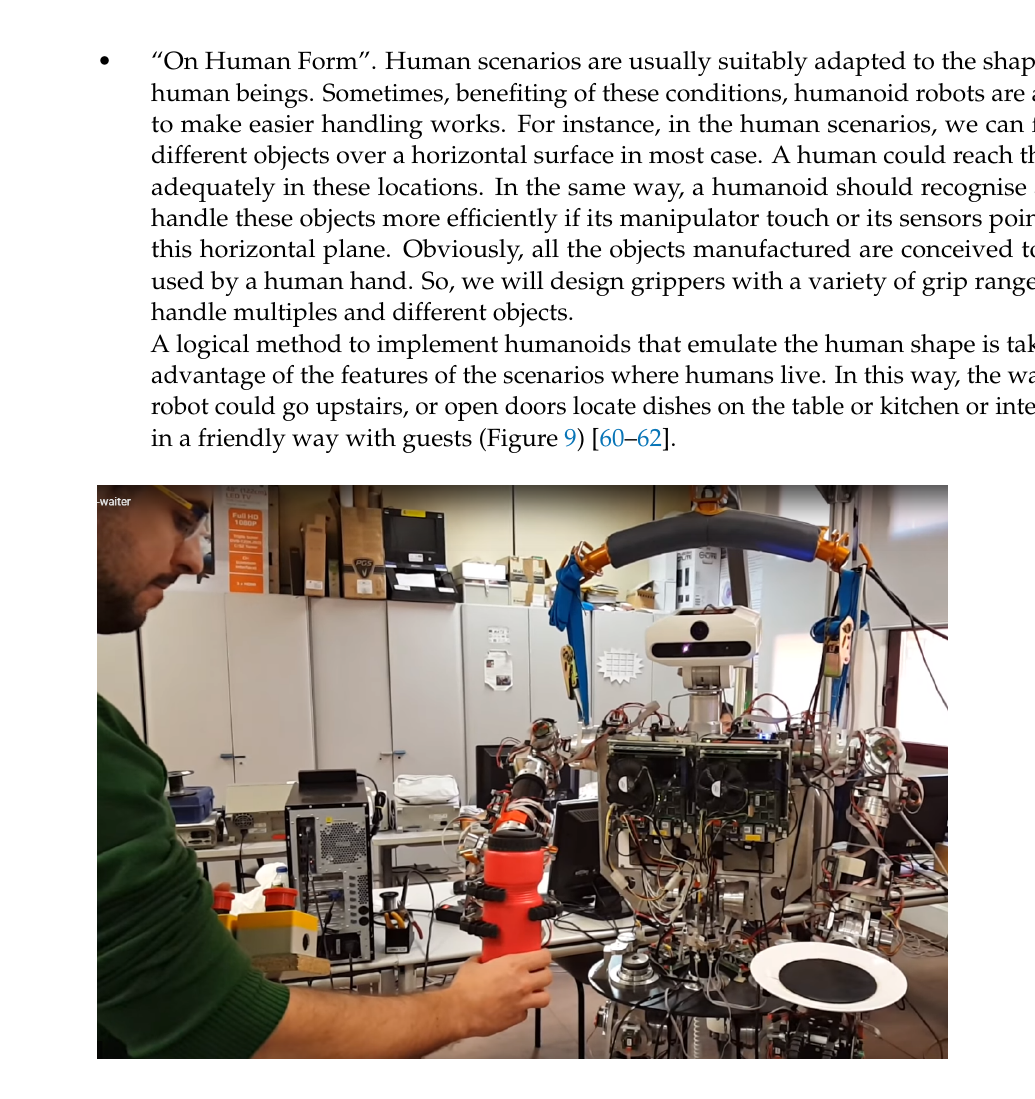
Figure 9. A possible and critical situation with a waiter robot while it is serving